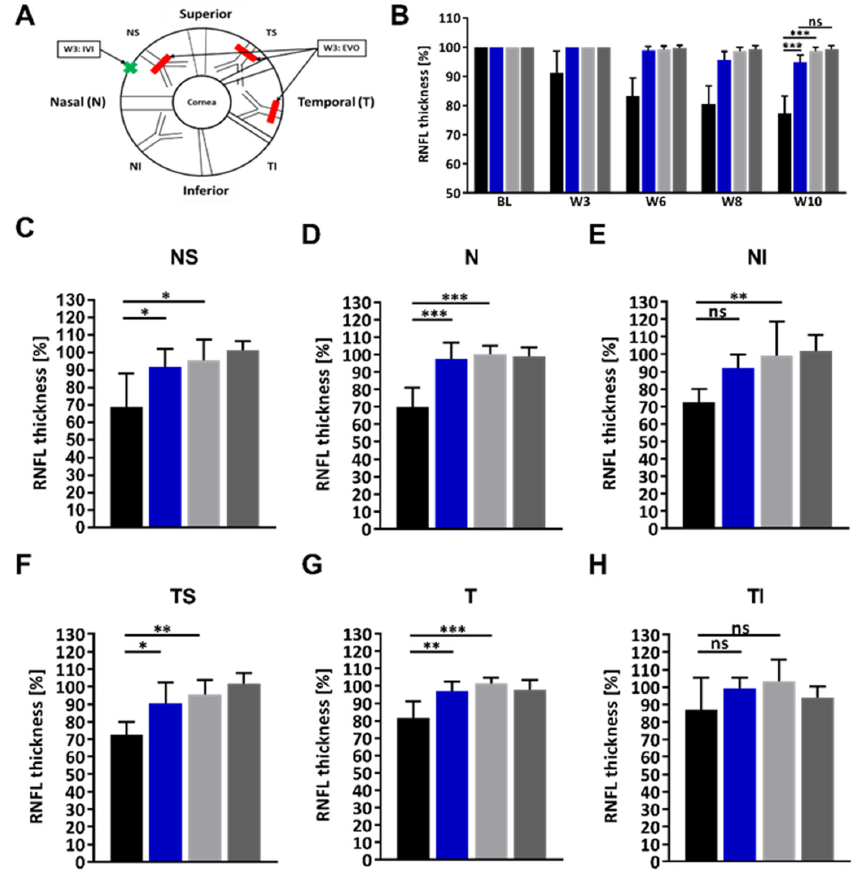
Figure 3. Quantification of the retinal nerve fiber layer thickness (RNFLT). To quantify the damage to the retina caused by the chronically elevated IOP in vivo, the retina was examined by optical coherence tomography (OCT). This allows retinal cross-sections to be imaged. The retinal nerve fiber layer was defined and quantified using a semi-automatic segmentation algorithm. For quantification, a 12° diameter circular B-scan was acquired. The Heidelberg Eye Explorer software divides the retina into the main sectors, superior (S), temporal (T), inferior (I), and nasal (N), as well as into the intermediate sectors, temporal superior (TS), temporal inferior (TI), nasal inferior (NI), and nasal superior (NS) ( A ). The scheme shows the interventions performed during the study on the eye, episcleral vein occlusion (EVO), and intravitreal injection (IVI) (scheme modified from [29] ). The mean RNFLT of the whole B-scan was used for follow-up quantification ( B ). Further quantification of the RNFLT at week 10 was performed for the individual sectors ( C–H ). Legend: black (IgG OS), blue (HMGB1 OS), light grey (IgG OD), dark grey (HMGB1 OD). * p < 0.05, ** p < 0.01, *** p < 0.001, not significant (ns), one-way ANOVA, Tukey’s HSD post hoc test.